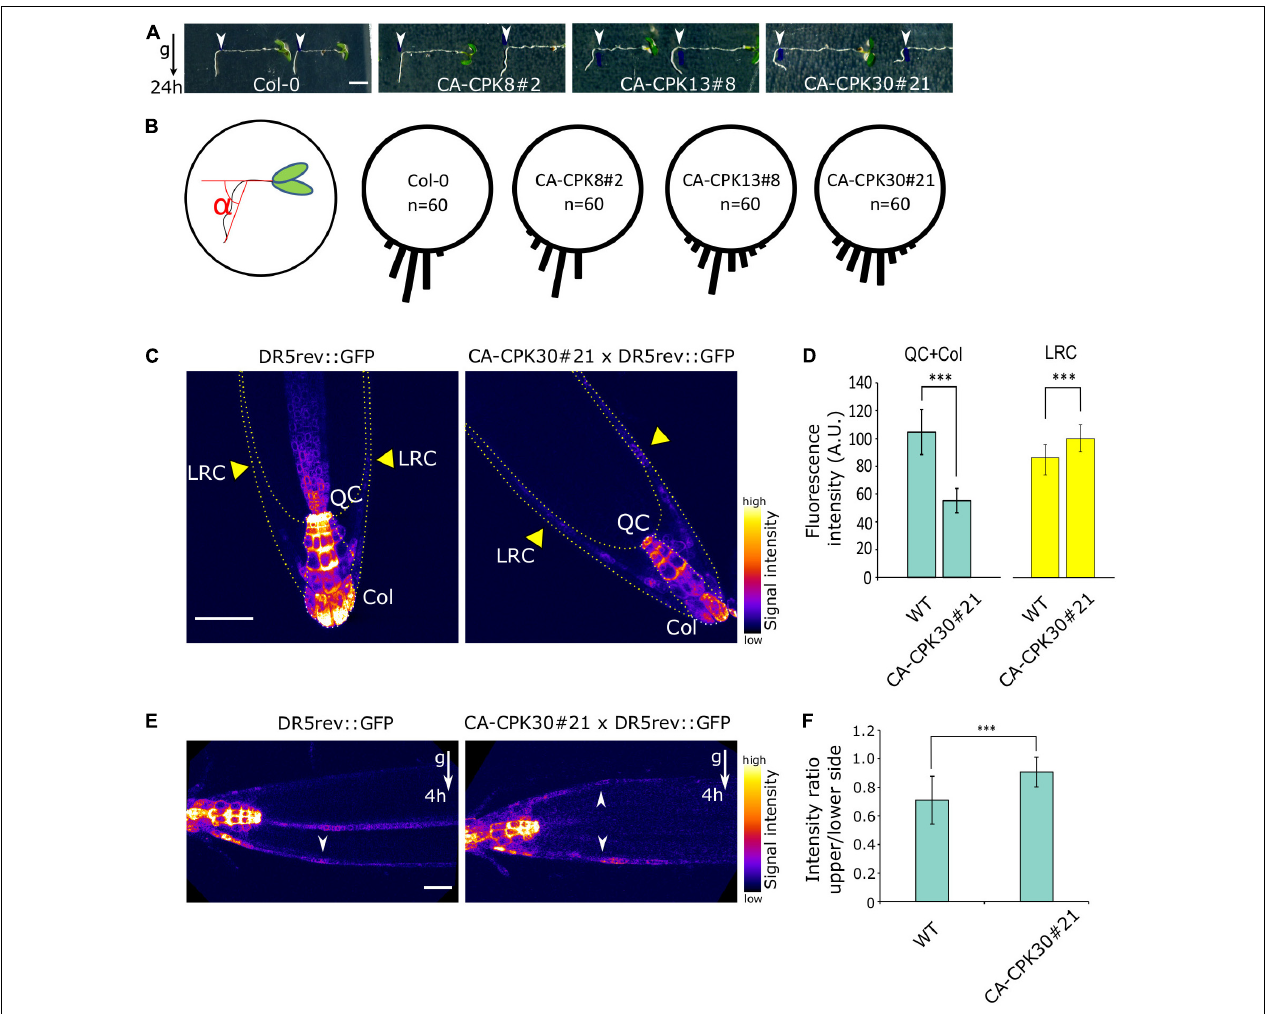
FIGURE 2 | Induction of CA-CPK30 causes agravitropic root growth. (A) Analysis of the root gravitropic response of Col-0, CA-CPK8#2, CA-CPK13#8 and CA-CPK30#21. 5-day-old seedlings were transferred to 2.5 µ M β -estradiol medium and immediately gravistimulated for 24 h (90 degree rotation). White arrowheads mark the position of the root tip at the moment of transfer. Scale bar = 0.2 cm. (B) Quantification of the root angle distribution of (A) . n = 60 is the total number of roots analyzed from two replicates for each genotype. (C) Expression pattern of the auxin output response marker DR5rev::GFP in WT and CA-CPK30#21 backgrounds. 6-day-old seedlings were transferred to 2.5 µ M β -estradiol medium for a 2 day induction. Yellow arrowheads indicate the lateral root cap (LRC). QC and Col, are quiescence center and columella, respectively. Scale bar = 50 µ m. (D) Quantification of DR5rev::GFP fluorescence in WT and CA-CPK30#21 (shown in C ), in the quiescence center and columella, lateral root cap. Measured areas are indicated in (C) by dashed lines. For DR5rev::GFP n = 12 in total, for CA-CPK30#21 × DR5rev::GFP n = 10 in total, from two replicates. Data are presented as the mean ± SD. (Unpaired Student’s t -test; ∗∗∗ P ≤ 0.001). (E) Expression pattern of the auxin output response marker DR5rev::GFP in WT and CA-CPK30 in response to gravity. 6-day-old seedlings were transplanted onto 2.5 µ M β -estradiol-containing medium for 2 day induction, followed by a 4 h gravistimulation (90 degree rotation). Scale bar = 20 µ m. (F) Quantification of intensity ratio between the upper/lower side for DR5rev::GFP fluorescence in WT and CA-CPK30#21 (shown in E ). Across 3 replicates, n = 17 for DR5rev::GFP and, n = 24 for CA-CPK3#21 × DR5rev::GFP. Data are presented as the mean ± SD. (Unpaired Student’s t -test; ∗∗∗ P ≤ 0.001).